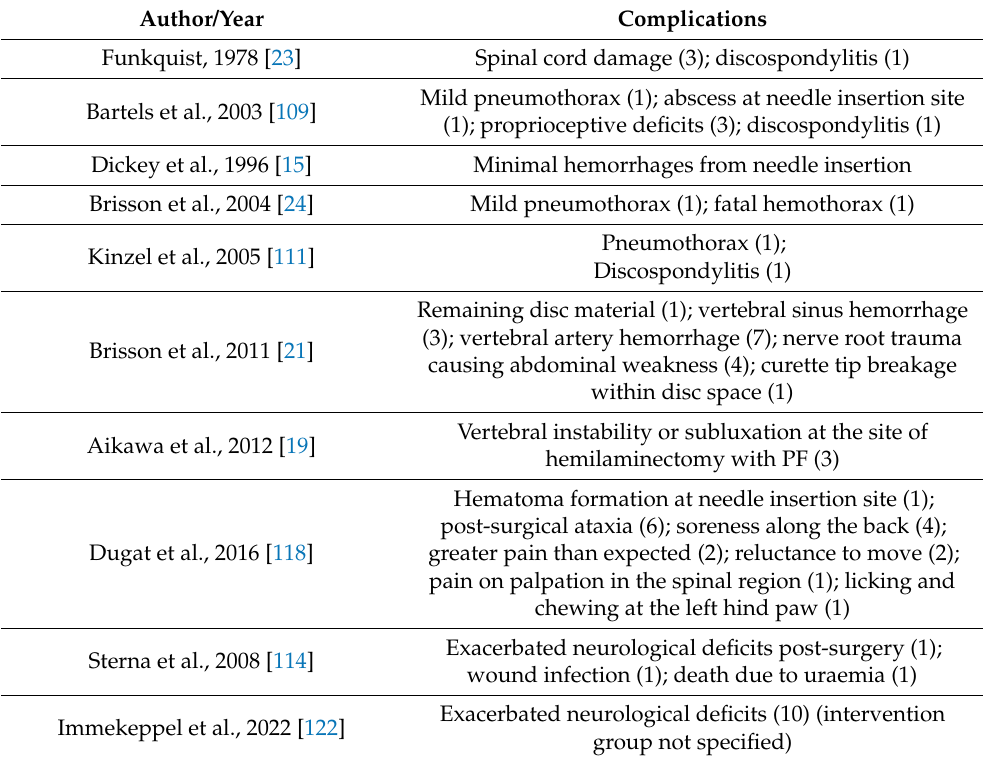
Table 6. Complications associated with PF (number of